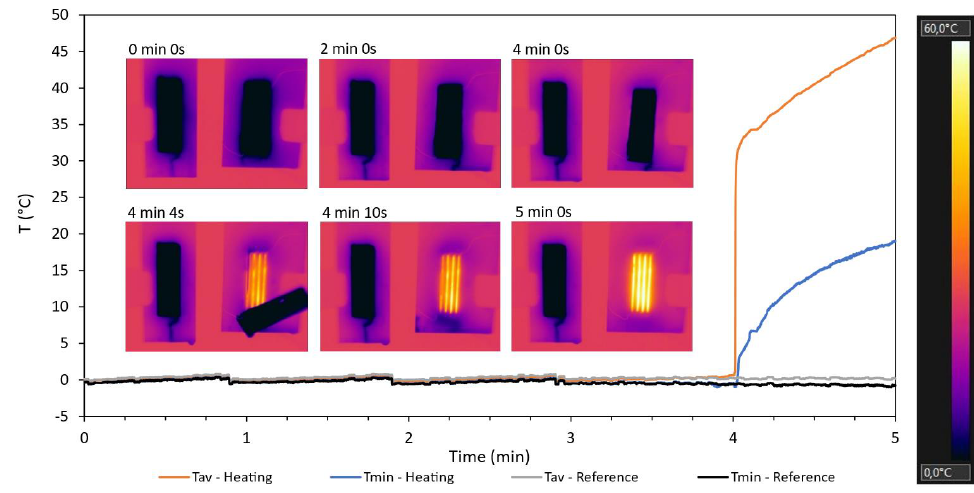
Figure 9. Deicing test with IR images taken at different times.